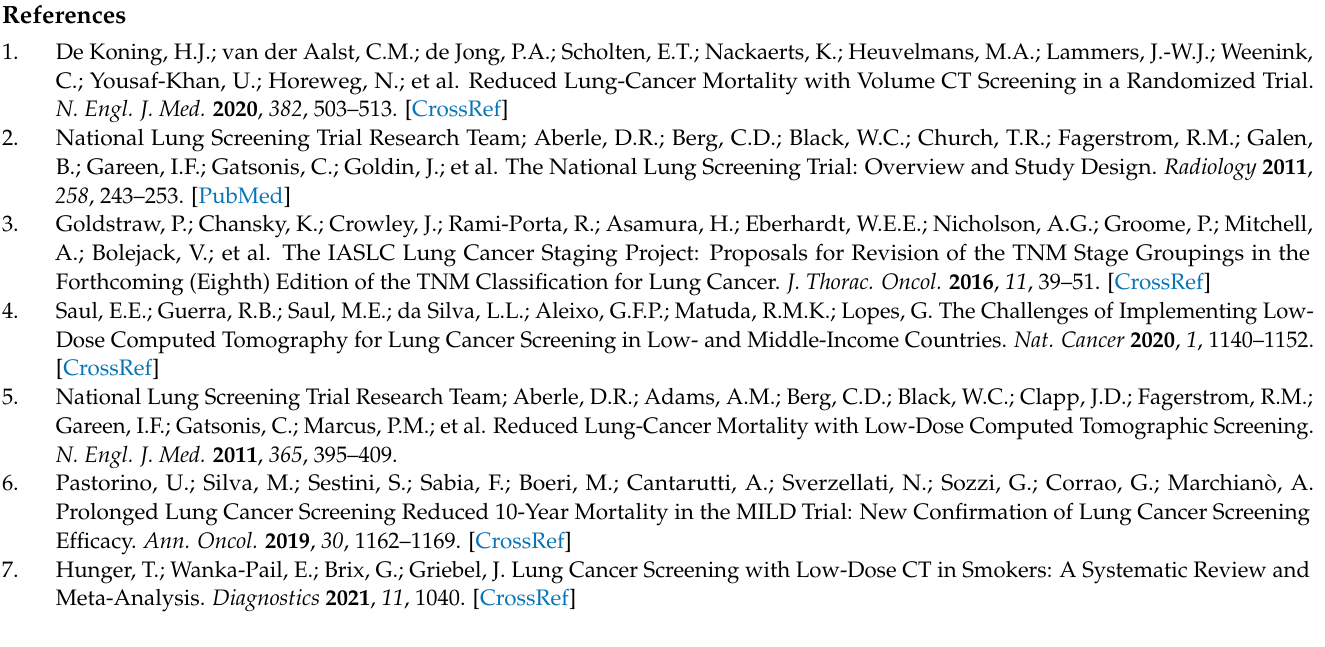
Table S5. Radiomic features extracted from the VOIs in this study, Table S6. Characteristics of the proposed radiomics study according to the reporting guidelines provided by the Image Biomarker Standardization Initiative (IBSI) [Chapter